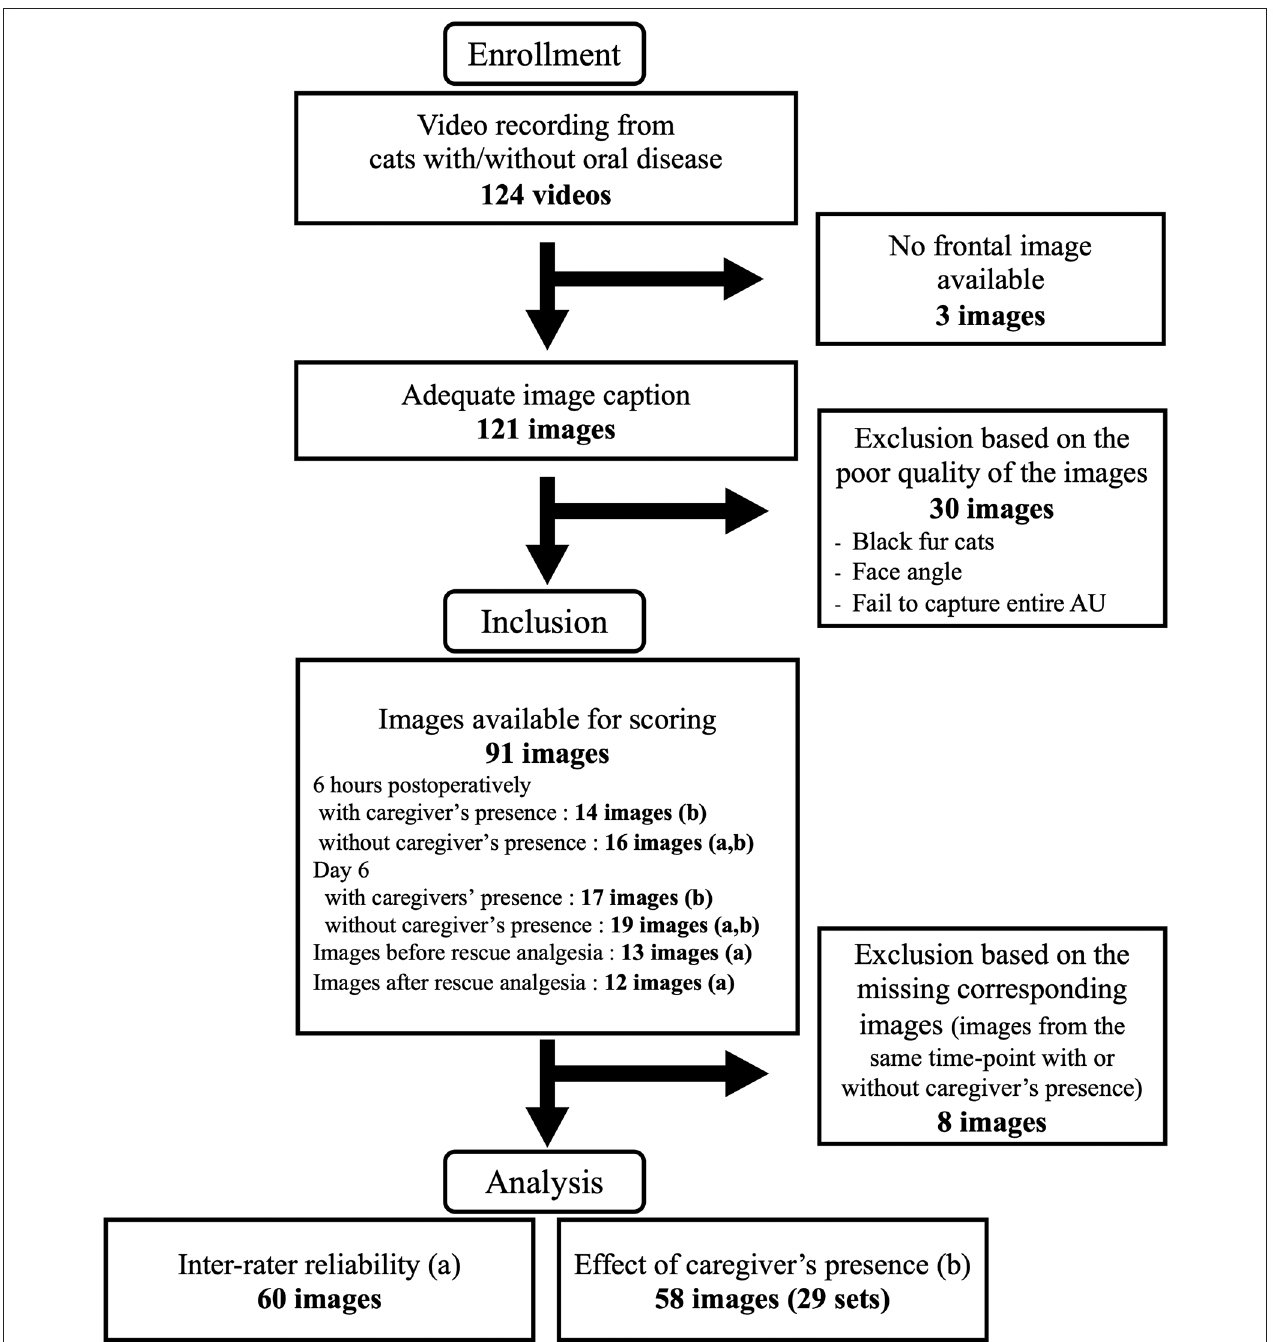
FIGURE 1 | Flowchart of images captured from 24 cats with oral disease included in the study. Images with (a) and (b) were included for the analyses of inter-rater reliability and the effect of caregiver’s presence, respectively.